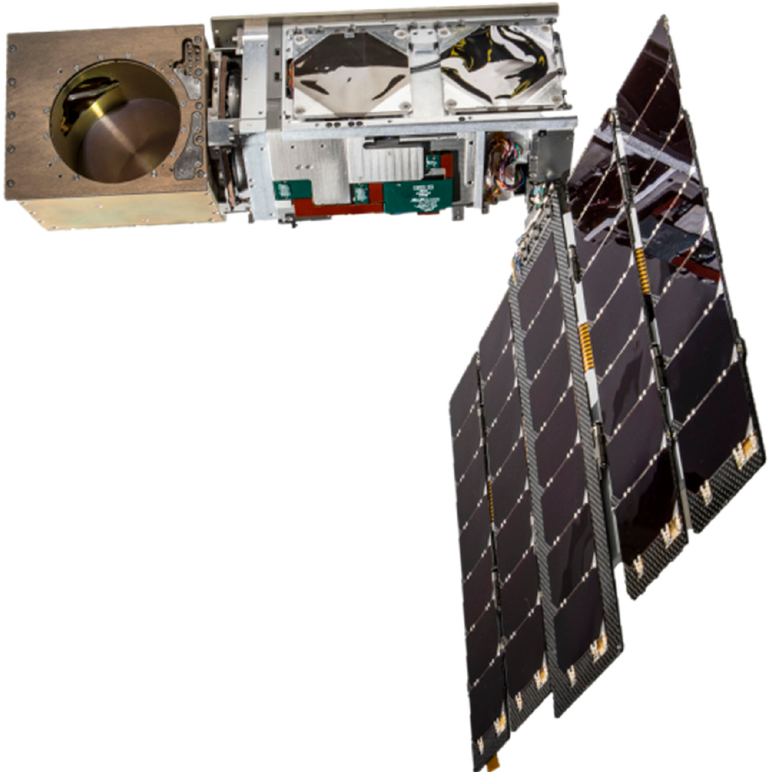
Figure 1. TROPICS CubeSat showing the spacecraft bus, radiometer (on the left), and deployed articulated solar array.